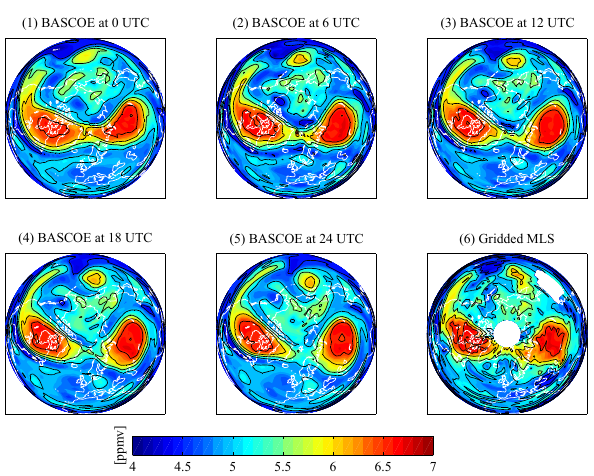
Fig. 3. BASCOE water vapour analyses (ppmv) at 00:00, 06:00, 12:00, 18:00 and 24:00UTC on 24 January 2009 at 850K (panels 1–5, respectively); gridded MLS water vapour observations (ppmv; 24-h average) on 24 January 2009 at 850K (panel 6). Red indicates relatively high values; blue indicates relatively low values. White areas in panel 6 indicate a lack of